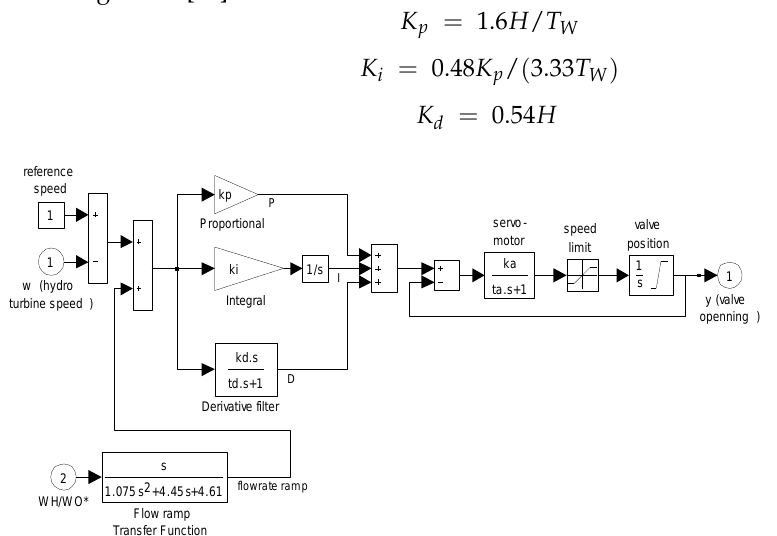
Figure 3. Hydro turbine speed governor Simulink schematic.